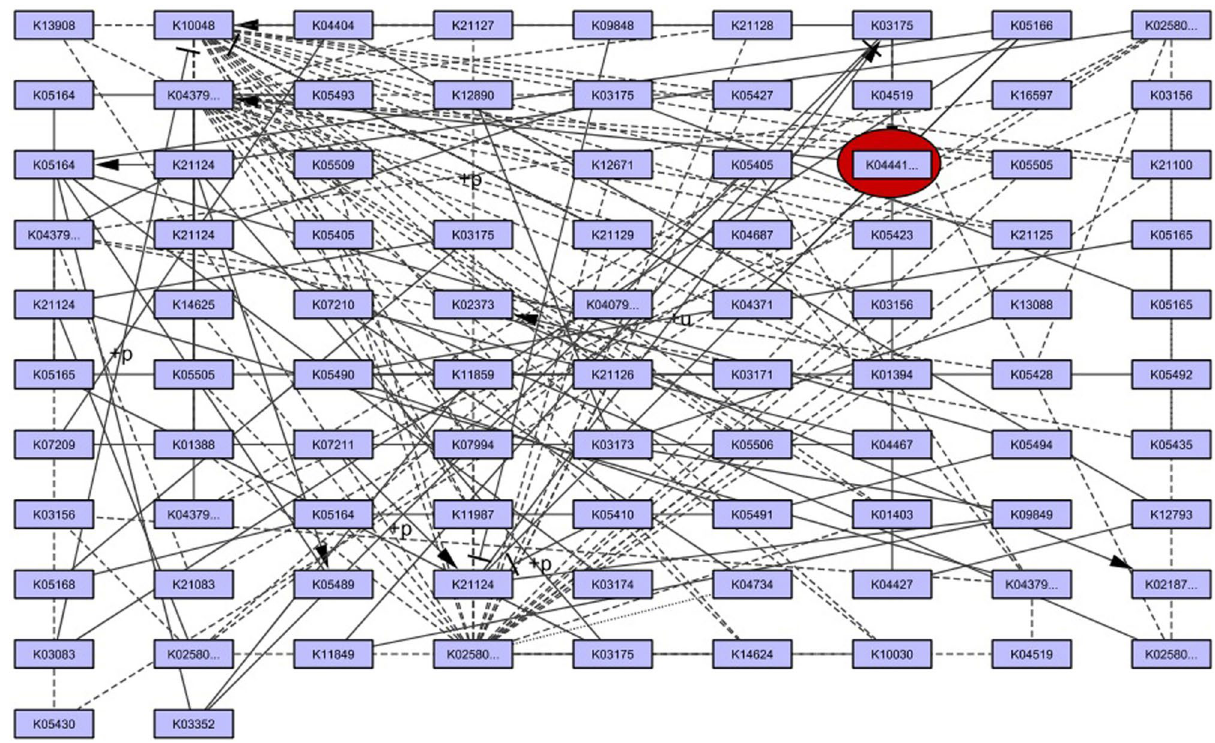
Figure 1. The signaling pathway of MAPK6/ERK3.